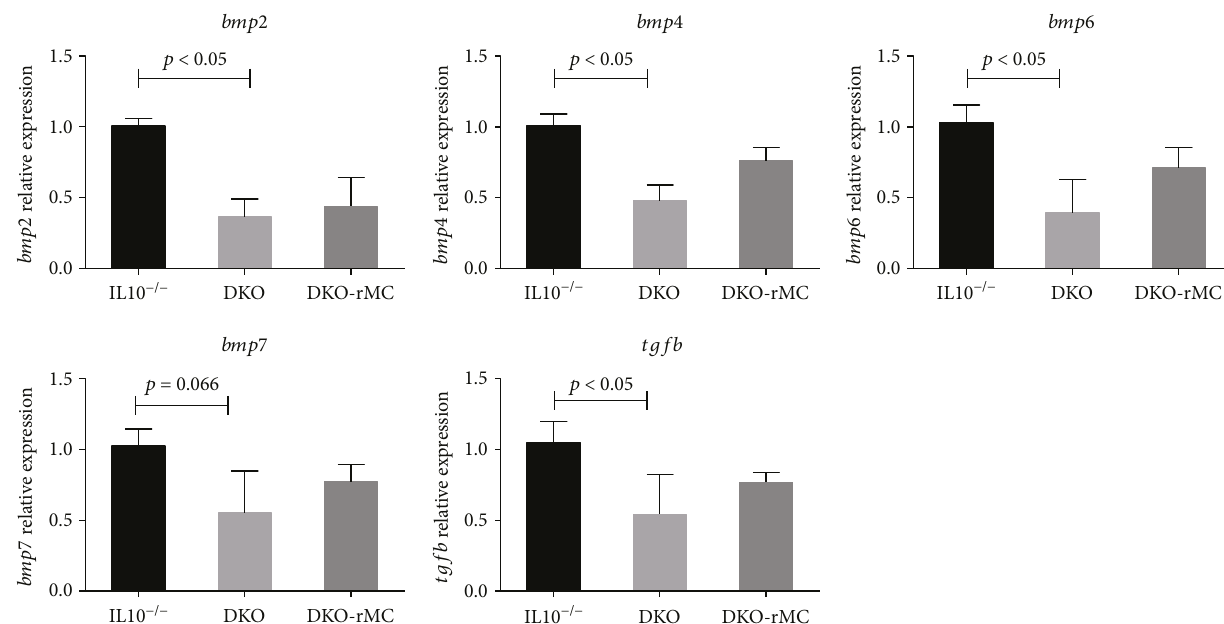
Figure 6: Relative expression of bmp genes and tgfb genes in colonic mucosa as in fl uenced by mast cell de fi ciency and systemic reconstitution. Genes are expressed relative to IL10 − / − mice values as described in the PCR array material and